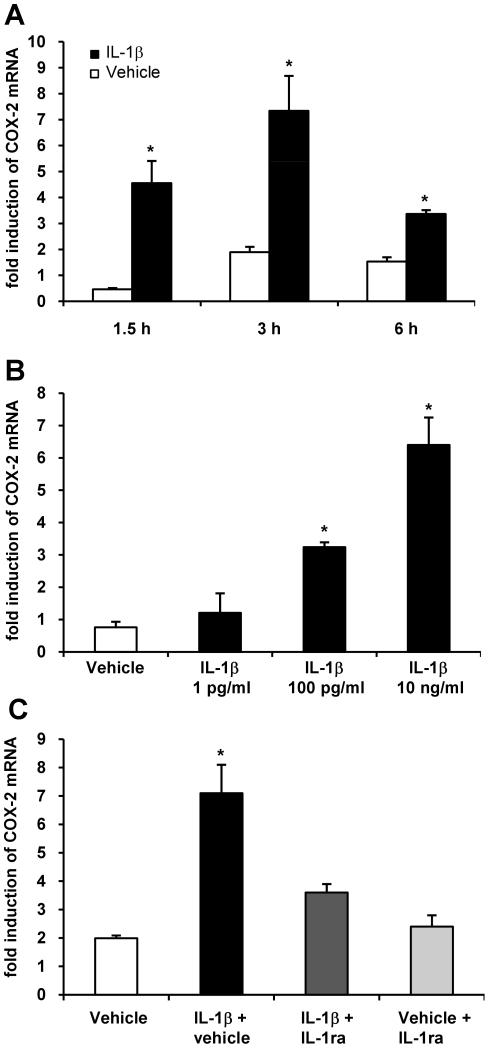
Expression of COX-2 mRNA in trigeminal ganglia cell culture following IL-1β incubation.Induction of COX-2 mRNA was time (A) and dose dependent (at the 3 hours time point; B). COX-2 mRNA expression was maximal after 3 hours (A) and at the IL-1β dose of 10 ng/ml (B) (n = 4-5/group). Co-incubation with the IL-1ra led to a significantly reduced COX-2 mRNA induction rate after 3 hours indicating the specificity of the effect (C). Application of the IL-1ra + vehicle resulted in a minor COX-2 mRNA induction rate comparable to vehicle administration (n = 3). Values are expressed as mean ± SEM. * p<0.05 compared to vehicle.